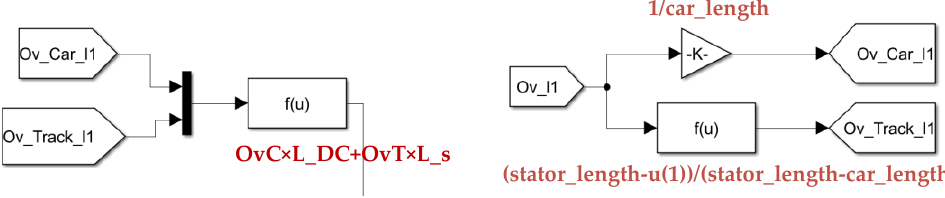
Figure 6. Part A of the motor model.